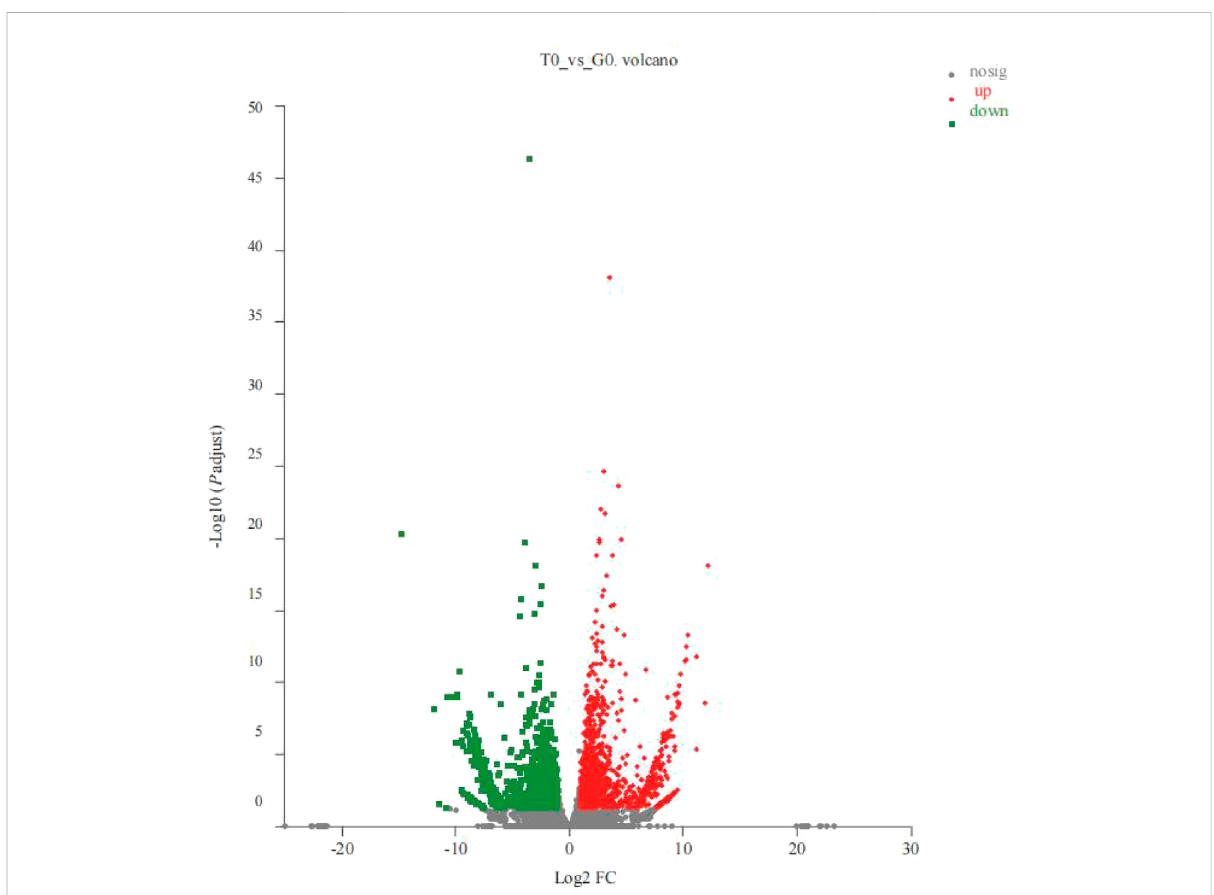
FIGURE 1 Volcano plots for the DEGs derived from the 2 groups (T0 vs. G0 groups). In the volcano plot described above, the X-axis represented the differences in the gene expressions observed between the 2 groups. The Y-axis depicts the statistical signi fi cance of the difference in gene expressionlevels.Thereddotsdenotethesigni fi cantlyupregulatedgenes,thegreendotsdepictthesigni fi cantlydownregulatedgenes,andthegray dots describe the insigni fi cant differential gene expression. P -adjust < 0.05 (For interpreting the color scheme used in the fi gure legends, the readers can refer to the web version of the research